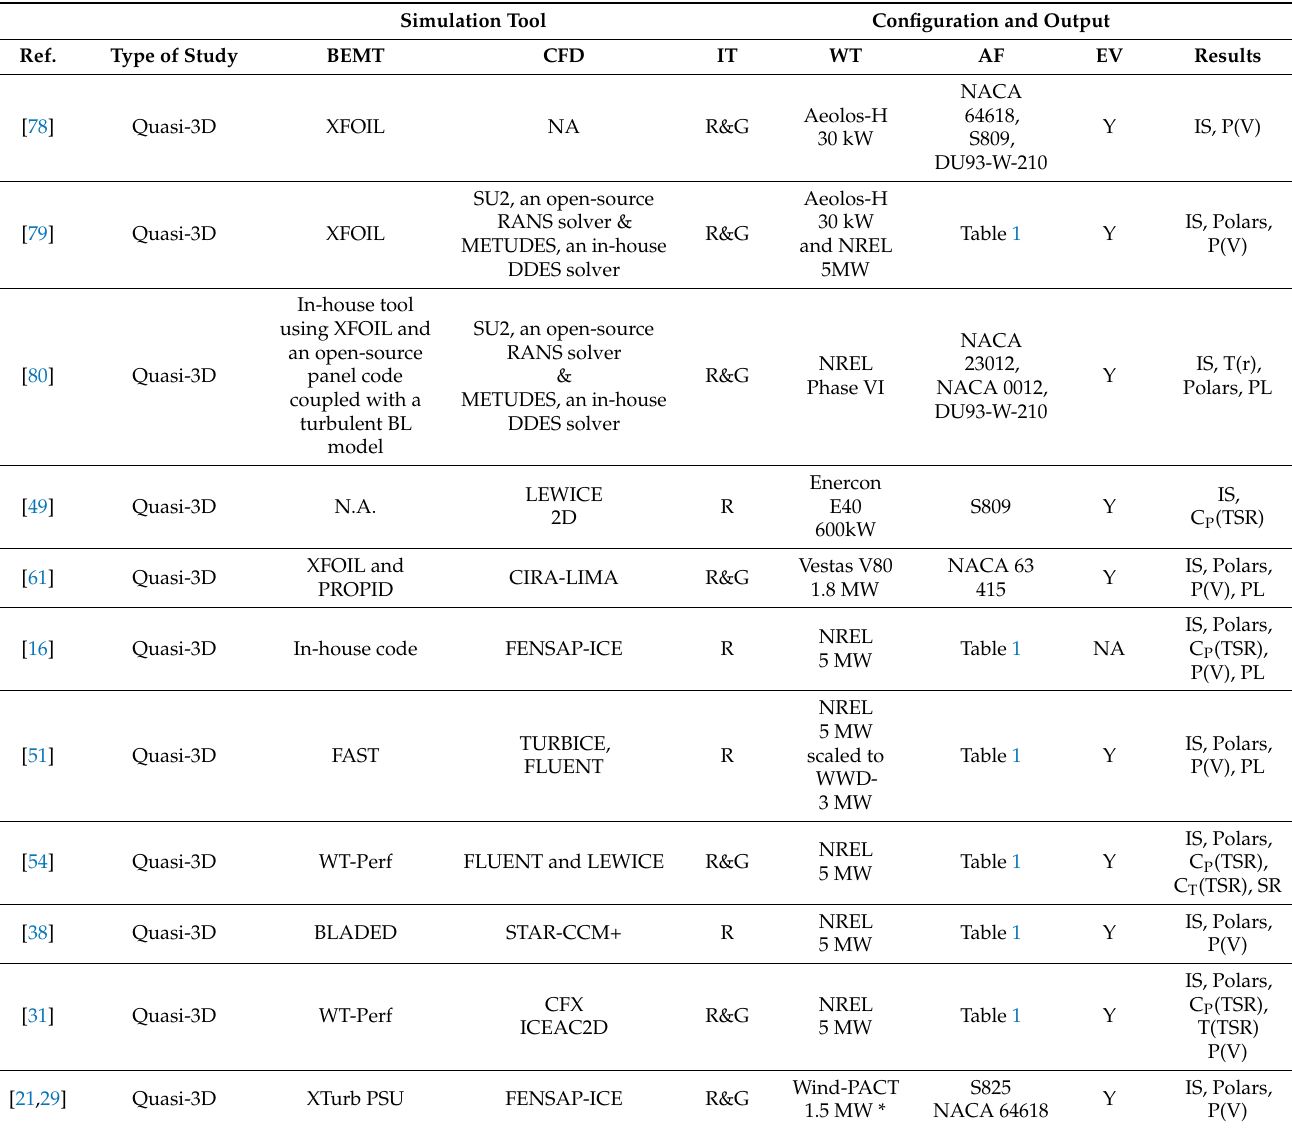
Table 2. Synopsis of the research on 3D and Quasi-3D wind turbine icing simulation. Simulation